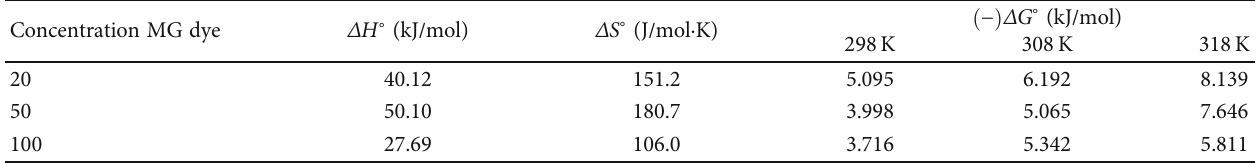
Table 4: Thermodynamic factors for adsorption of MG on Fe volume — 0.05L, pH — 7, and agitation — 100